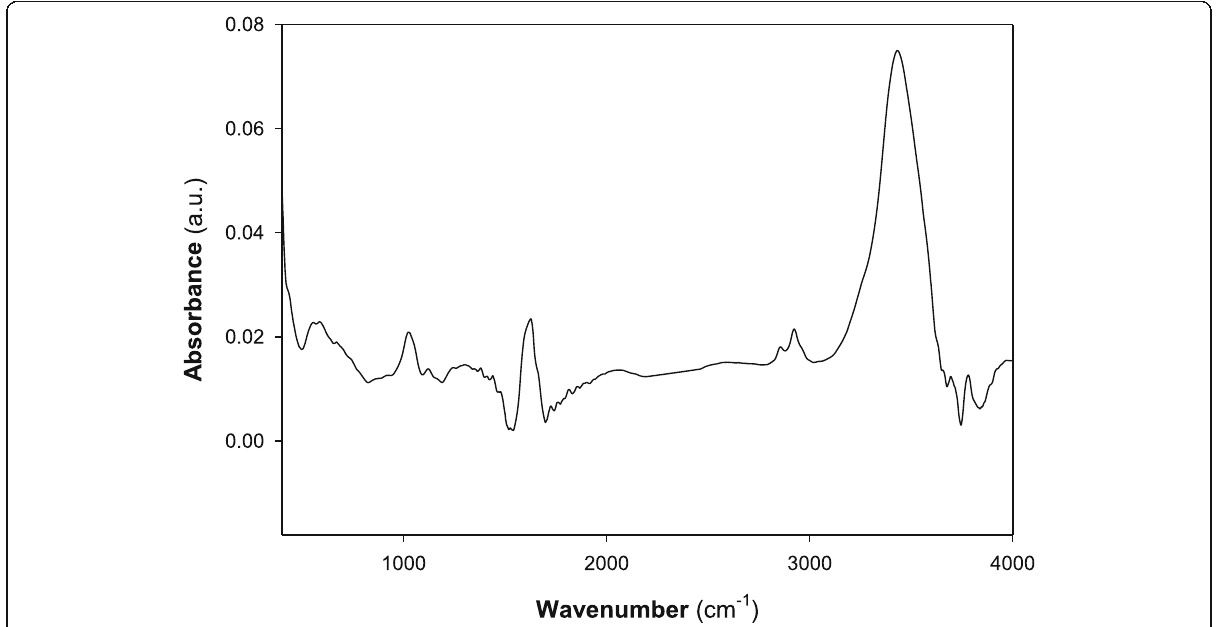
Fig. 5 FTIR spectroscopic analysis of the biosynthesized AgNPs through the mediation by A. fumigatus DSM819